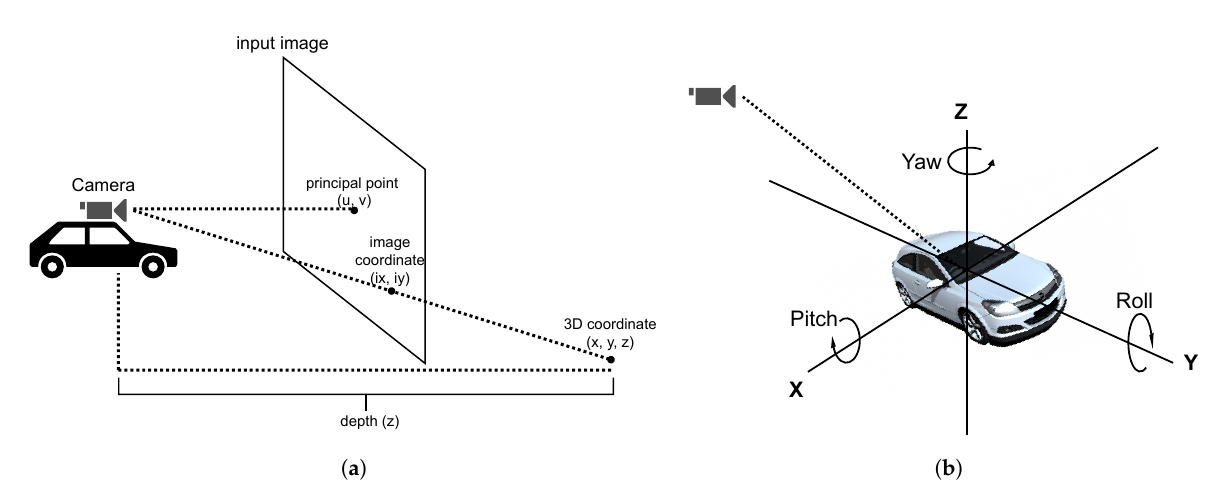
Figure 2. ( a ) The camera perspective from the top of the autonomous vehicle. All images in the dataset are taken by this camera. The principal point (u, v), at the center of an image, is the point on the image plane onto which the perspective center is projected. With a given camera intrinsic matrix, we can obtain a conversion between a point’s 3D coordinate (x, y, z) in the world space and its 2D coordinate, denoted as (ix, iy), in the image space. ( b ) Six degrees of freedom (6DOF) can be used to determine the absolute pose of a vehicle in the world space. Rotation around the side-to-side (X) axis is called pitch; rotation around the front-to-back (Y) axis is called roll; and rotation around the vertical (Z) axis is called yaw.